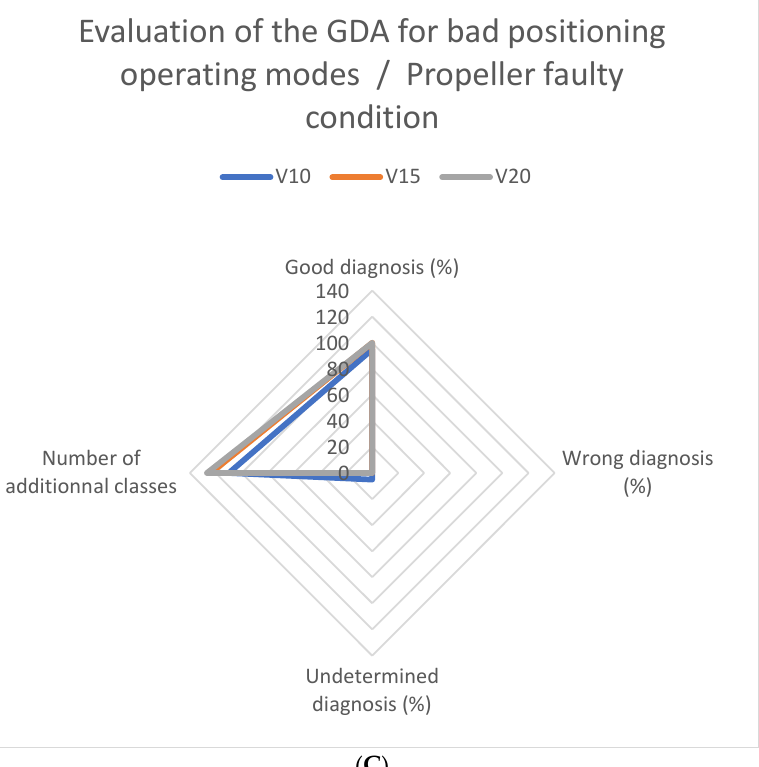
Figure 14. Evaluation of GDA for all operating modes. The ( A ) graph is for the comparison of the normal mode with the bad fan position. ( B ) is for the comparison between normal condition with the propeller faulty mode. ( C ) is for the comparison of bad fan position with propeller faulty